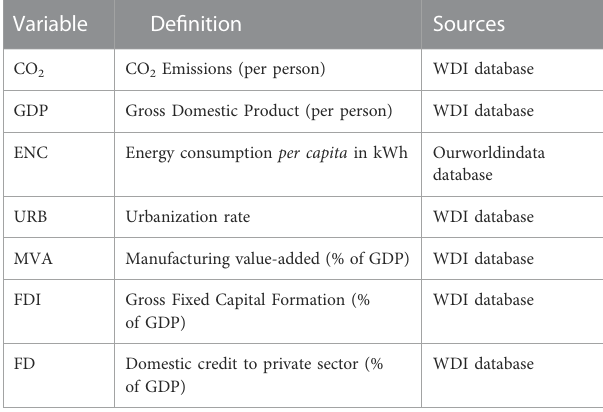
TABLE 1 Variables and Data